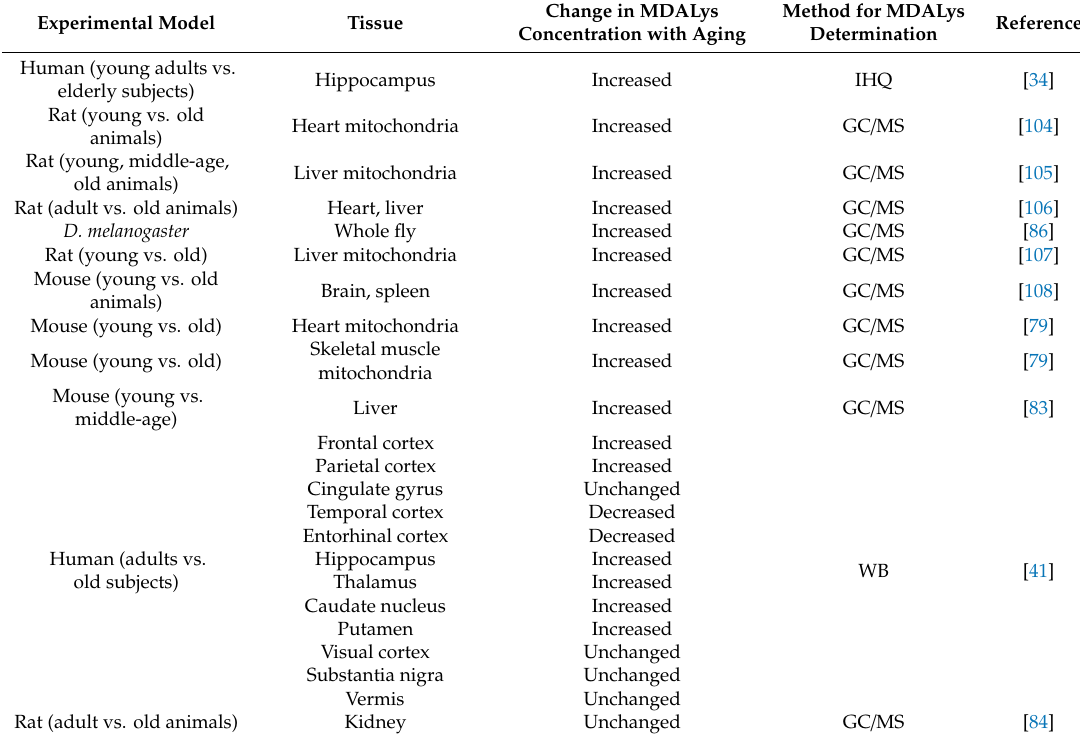
Table 3. E ff ect of aging on the steady-state level of MDALys in tissues from di ff erent species. Experimental Model Tissue